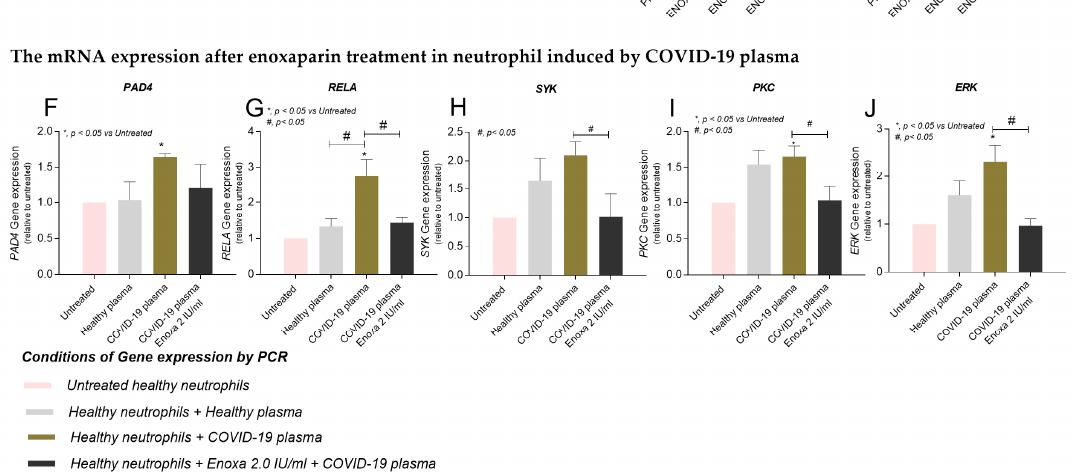
Figure 2. The effect of enoxaparin pretreatment on NETs induced by COVID-19 plasma in vitro. Representative fluorescence images captured by confocal microscope (original magnification 630X with scale bars indicate image size as labelled 20 μ m) of isolated neutrophils from healthy controls pretreated with or without enoxaparin (0.5, 1 and 2 IU/mL) and incubated with COVID-19 plasma from severe cases ( n = 5), stained with DAPI (blue), neutrophil elastase (green) and myeloperoxidase (red), and merged images for NET identification ( A ). The percentages of NETting neutrophils ( B ), the levels of dsDNA ( C ), NE ( D ) and Histone–DNA complexes ( E ) in the supernatants from healthy neutrophils pretreated with or without enoxaparin (0.5, 1 and 2 IU/mL) and incubated with COVID-19 plasma. The mRNA expression levels of PAD4 ( F ), RELA ( G ), PKC ( H ), SYK ( I ) and ERK ( J ) from healthy neutrophils pretreated with enoxaparin (2 IU/mL) and incubated with or without COVID-19 or healthy control plasma ( n = 5 for all groups) (Supplemental Table S2). Abbreviations: RELA , REL-associated protein involved in NF- κ B p65 subunit; Protein kinase C, PKC ; spleen tyrosine kinase, SYK ; extracellular signal- regulated kinases, ERK . ( A – E ) (* p < 0.05, ** p < 0.01 vs. plasma alone and # p < 0.05 vs. the indicated group) and ( F – J ) (* p < 0.05 vs. untreated and # p < 0.05 vs. the indicated